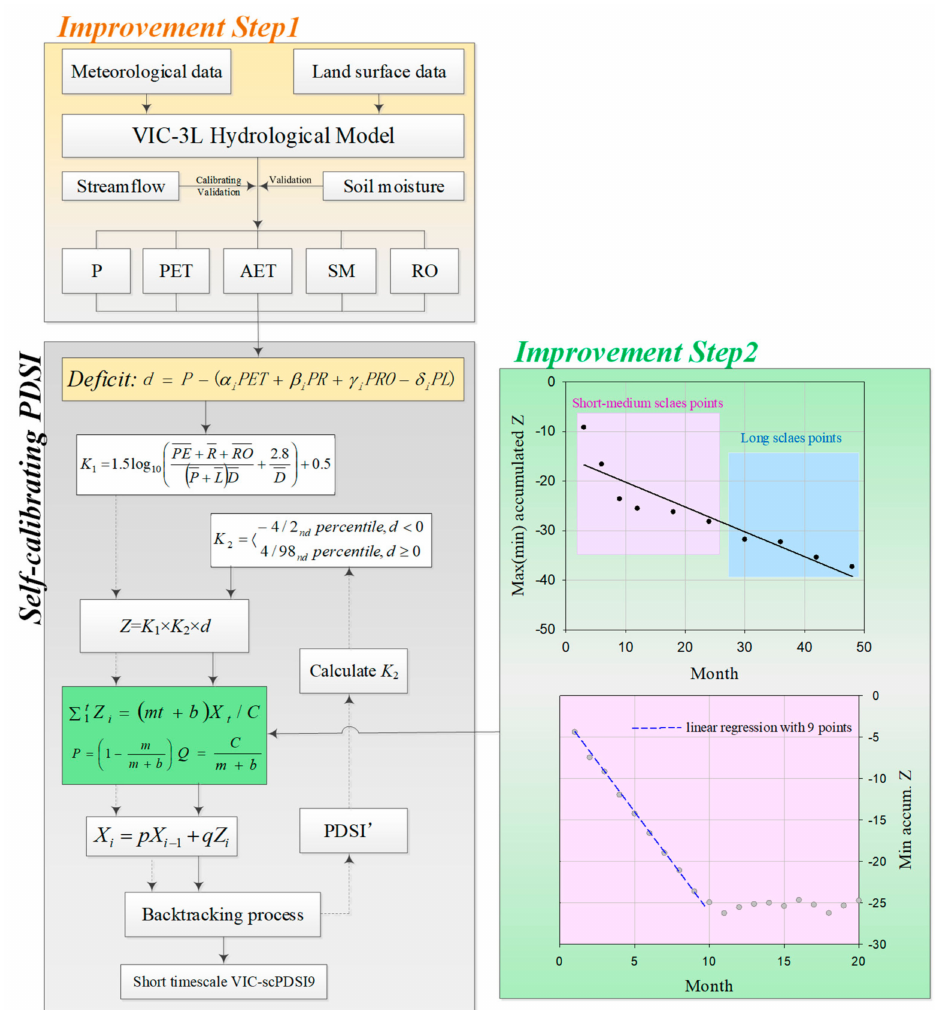
Figure 2. Flowchart of modified scPDSI’s procedure. The dashed arrows direct the computation process of PDSI, and the solid arrows denote the modifications in scPDSI. Improvement steps 1 and 2 show our improvements to the hydrologic accounting and standardization process,